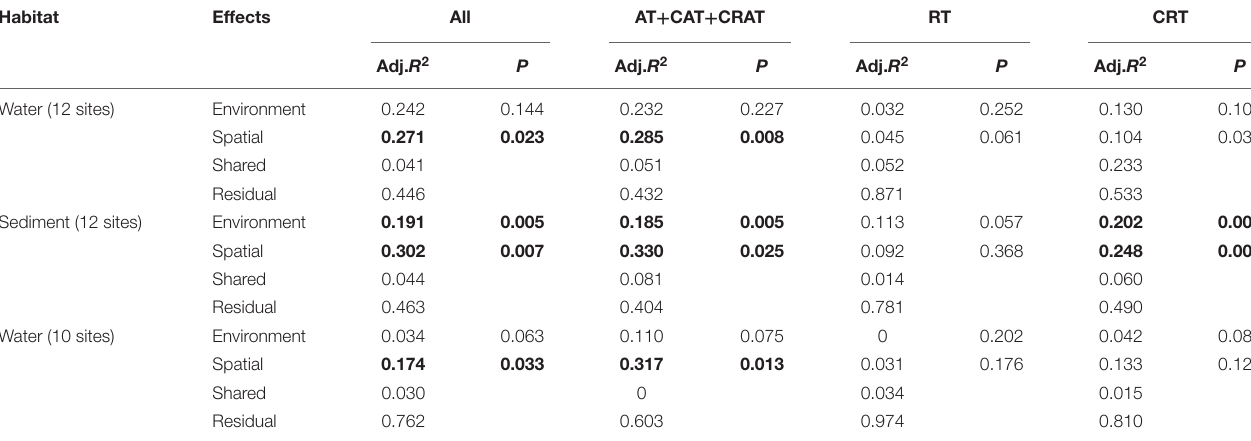
TABLE 2 | Variation partitioning of the microeukaryotic communities among environmental and spatial variables in water and sediment. Habitat Effects All AT + CAT + CRAT